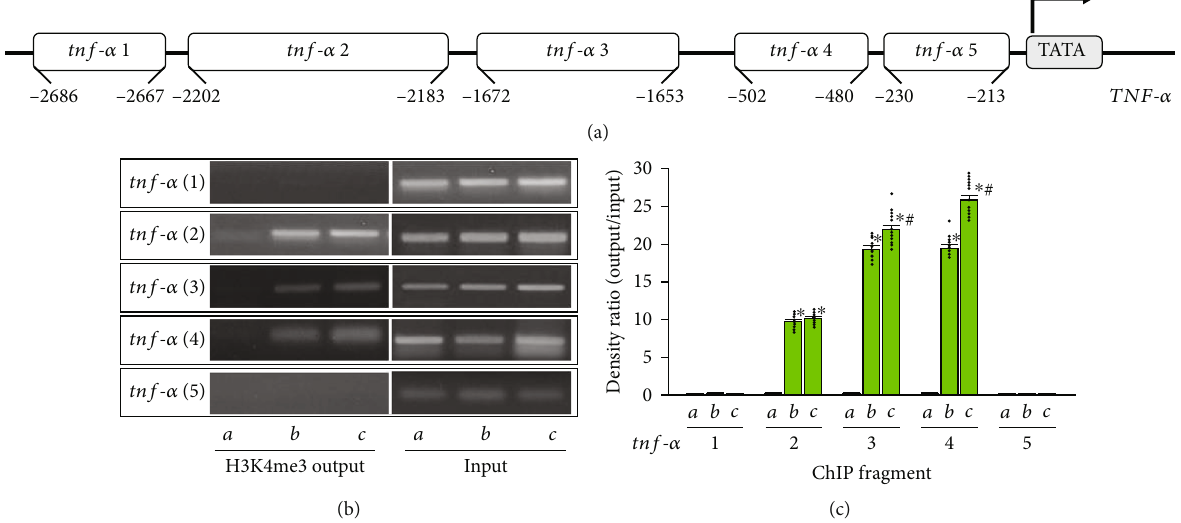
Figure 4: Prenatal opioid exposure activated di ff erential enhancement of H3K4me3 in the tnf - α promoter gene locus in the ventral-medial striatum. (a) The fi gure demonstrated the subregions relative to the transcription start site of tnf- α promoter gene locus as follows: tnf- α 1 ( − 2667 to − 2686), tnf- α 2 ( − 2183 to − 2202), tnf- α 3 ( − 1653 to − 1672), tnf- α 4 ( − 174 to − 496), and tnf- α 5 ( − 205 to − 224). (b) The panel illustrations indicate representative ChIP assay of the levels of trimethylated H3K4 in the tnf- α promoter gene locus at the subregions. The insets a , b , and c are as follows: the control group ( n = 12 rats), the early group ( n = 12 rats), and the late group ( n = 12 rats). (c) The e ff ects of prenatal opioid exposure in trimethylated H3K4 levels in the tnf- α promoter gene is summarized in three groups as described above. The DNA input signal served as the internal loading control and was not signi fi cantly di ff erent across lanes. Scatted dots represent the data points in each group. ∗ p < 0 : 05 , compared to the control group. # p < 0 : 05 , compared to the early group.